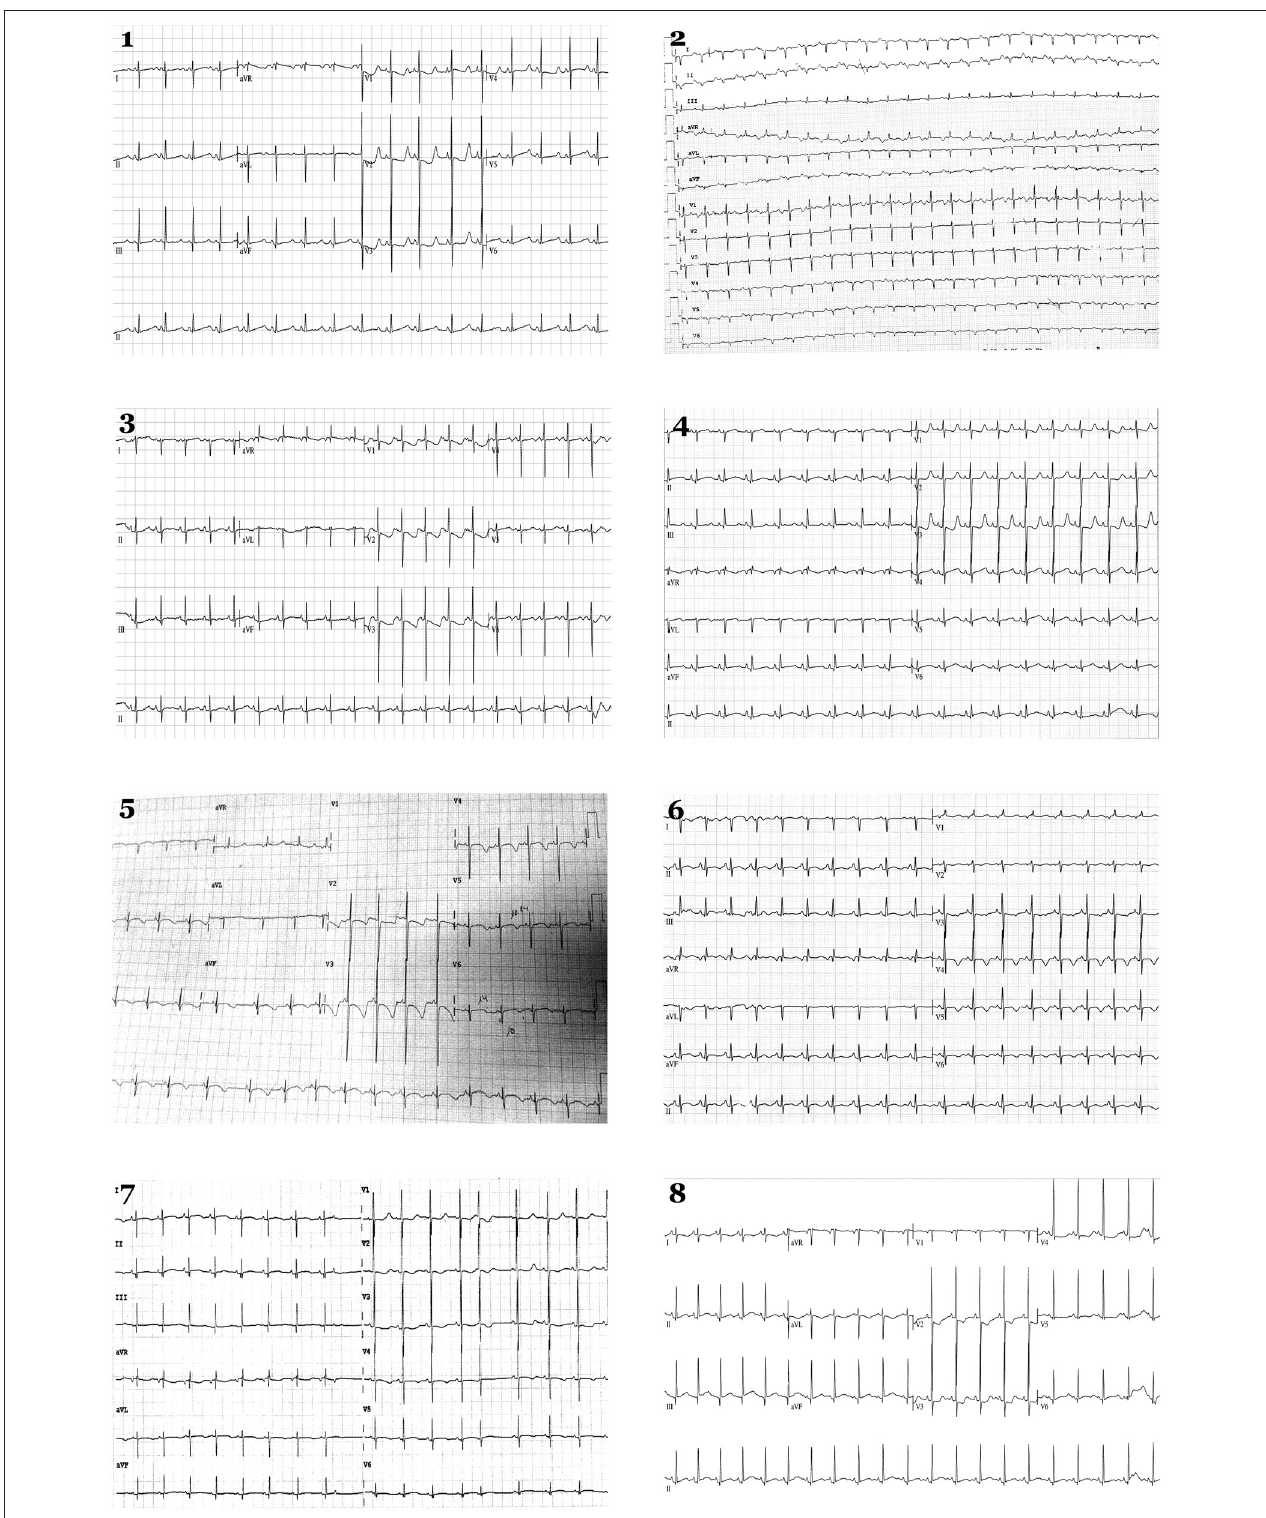
FIGURE 2 | Electrocardiograms in neonates. Eight newborns show a QTc > 480ms in the first 48h. Each number corresponds to index case of each family analyzed.